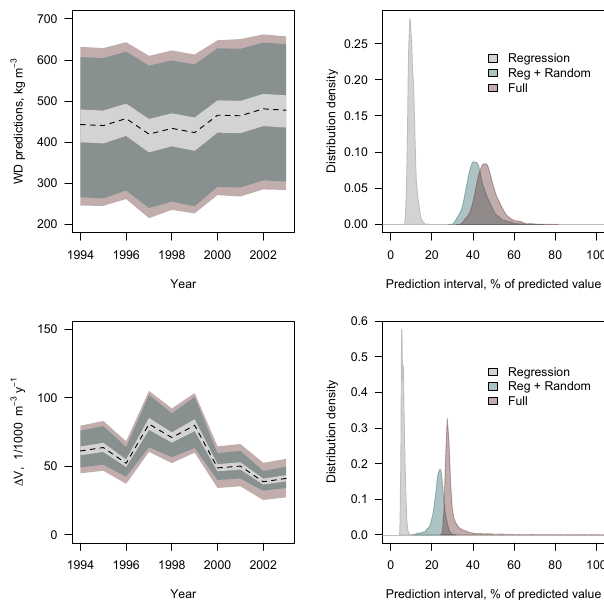
Figure 4. Left, variations of the MCMC annual predictions and pre- diction intervals (95%) of wood density and volume increment for one given tree, randomly chosen while accounting for different error sources: regression only/regression and random effects/regression, random effects and residual variance; right, distribution density of the relative prediction interval (expressed in percentage of the pre- diction) for all trees included in the simulation, according to the error sources